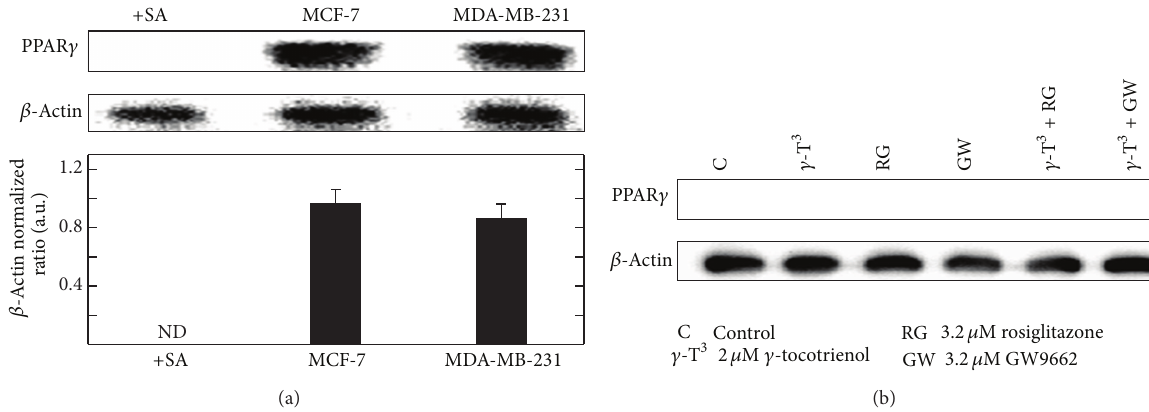
Figure 4: Western blot analysis to determine expression of PPAR 𝛾 in mammary cancer cells. (a) PPAR 𝛾 levels were determined in untreated +SA, MCF-7, and MDA-MB-231 cells and (b) PPAR 𝛾 levels were determined after treatment with 𝛾 -tocotrienol, rosiglitazone, and GW9662 alone or in combination in +SA cells. +SA, MCF-7, and MDA-MB-231 cells were initially plated at 1×1 0 6 cells/100 mm culture dish and treated with control or treatment media for 4-day incubation period. Afterwards, whole cell lysates were prepared from each treatment group for subsequent separation by polyacrylamide gel electrophoresis (50 𝜇 g/lane) followed by Western blot analysis. Scanning densitometric analysis was performed on all the blots done in triplicate and the integrated optical density of each bond was normalized with corresponding 𝛽 -actin, as shown in bar graphs below their respective Western blot images. Vertical bars in the graphs indicate the normalized integrated optical density of bands visualized in each lane ± SEM (arbitrary